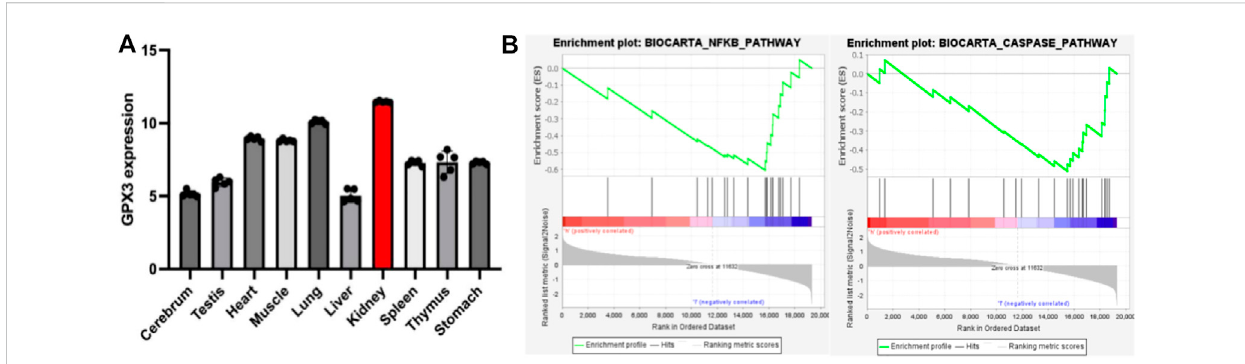
FIGURE 3 A) represents the statistical chart of the expression level of GPX3 in various tissues and organs under the physiological conditions of mice; (B) represents the enrichment of GPX3 pathways (NF κ B pathway and Caspase pathway) after single-gene GSEA analysis in the renal ischemia-reperfusion injury